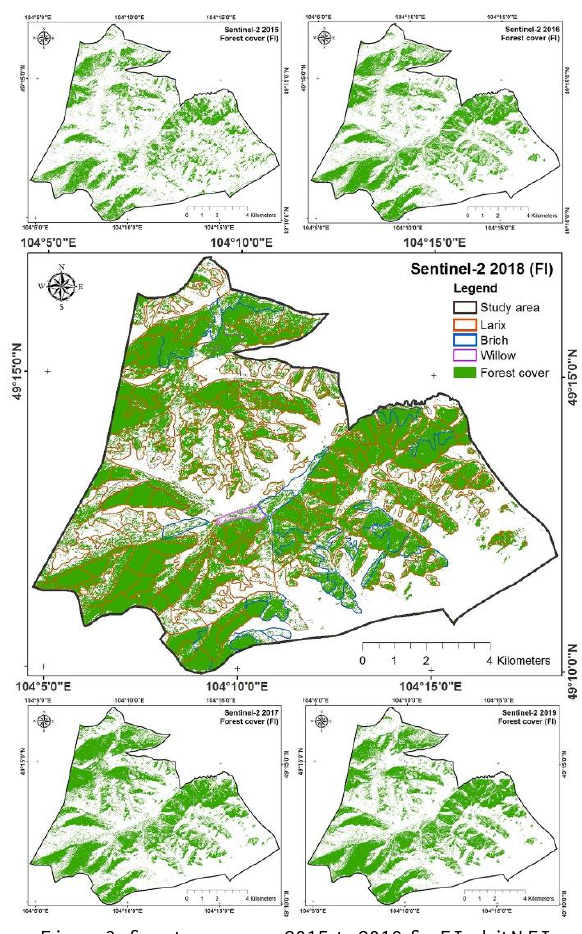
Figure 5. Field trip measured and forest cover validation map